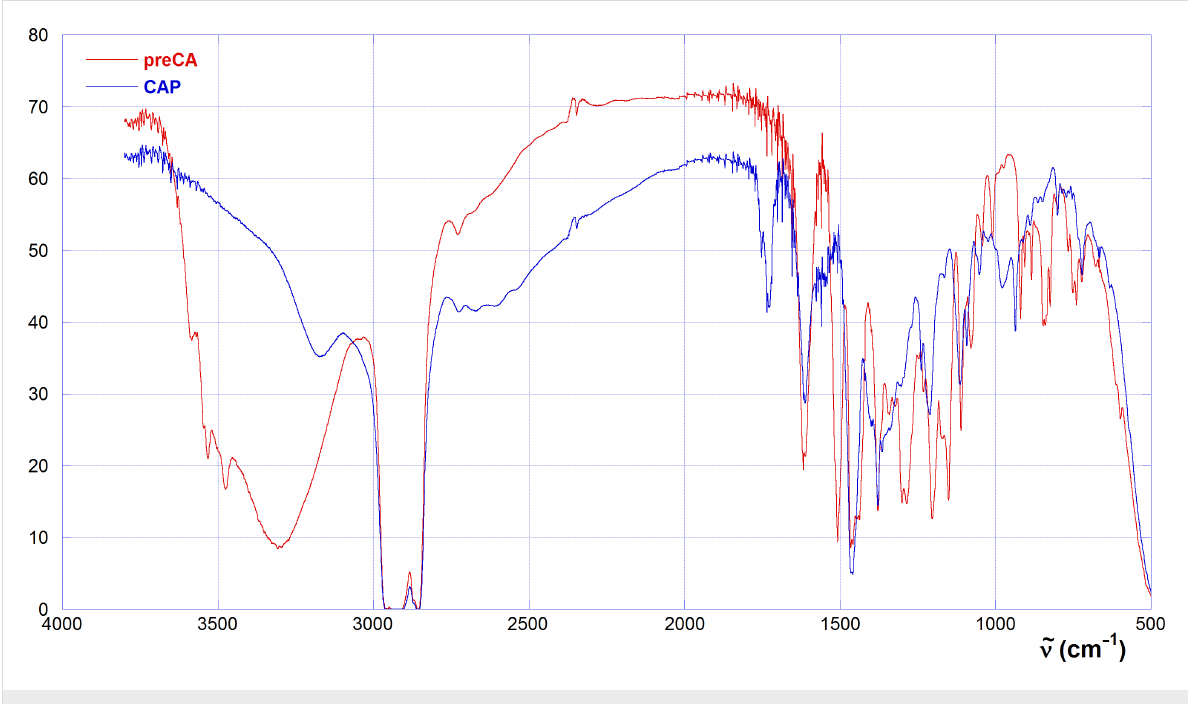
hydrogen bonding affects the flexibility of the macrocycle scaf- fold, as well as the possible double free rotation of the arene–CH 2 –proline single bond–single bond system. Hydrogen bonding is likely enforced by deprotonation of a phenol group, due to enhanced Coulomb interaction with ammonium